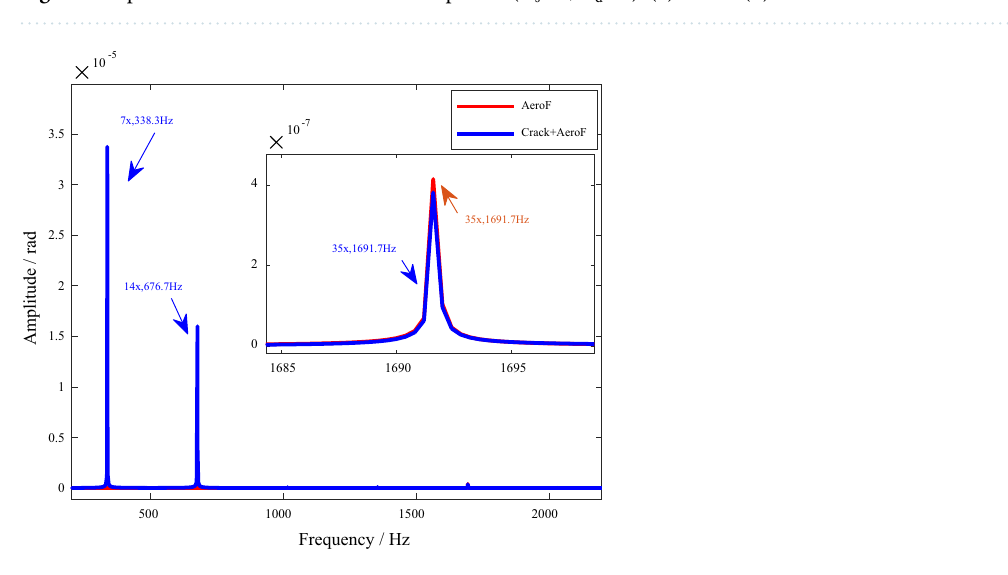
Figure 8. Spectrums of transverse vibration responses ( N s = 7, N d = 5). ( a ) AeroF. ( b ) Crack + AeroF.